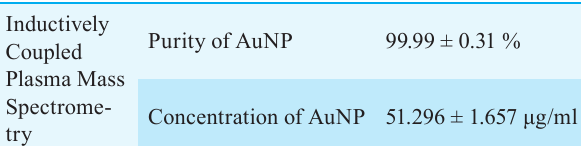
Table 4 Summary of chemical composition analysis of the 15 nm AuNPs.